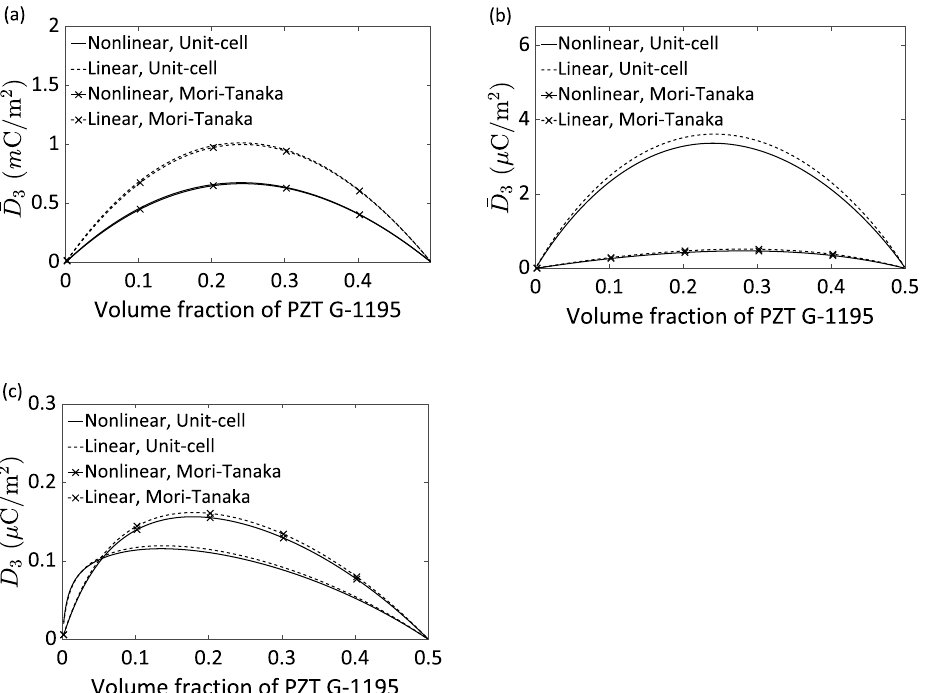
Figure 6. Effective electric displacement D 3 as a function of PZT G-1195 volume fraction for a stress-free Terfenol-D/PZT G-1195/Araldite D composite subjected to a constant magnetic field H 3 = 100 k A/m having 1–3 ( a ), 0–3 ( b ), and 2–2 ( c ) connectivities, respectively. The volume fraction of the Araldite D is fixed of 0.5, while the Terfenol-D and PZT G-1195 phases share the rest of the volume fraction, namely,